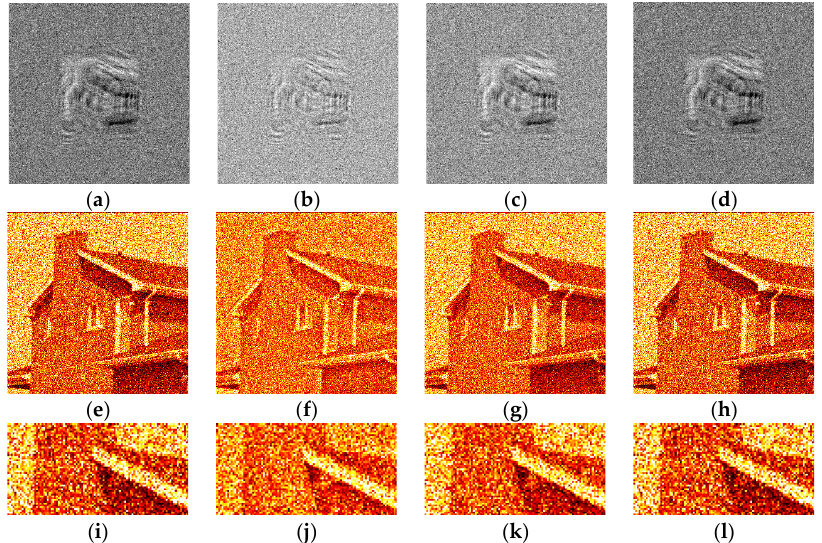
Figure 3. Examples of synthesized binary inline Fresnel holograms containing the “House” image, corresponding reconstructed images and their enlarged fragments. Holograms were binarized using the Otsu ( a , e , i ), Sauvola ( b , f , j ), Li ( c , g , k ), and Huang ( d , h , l ) methods.